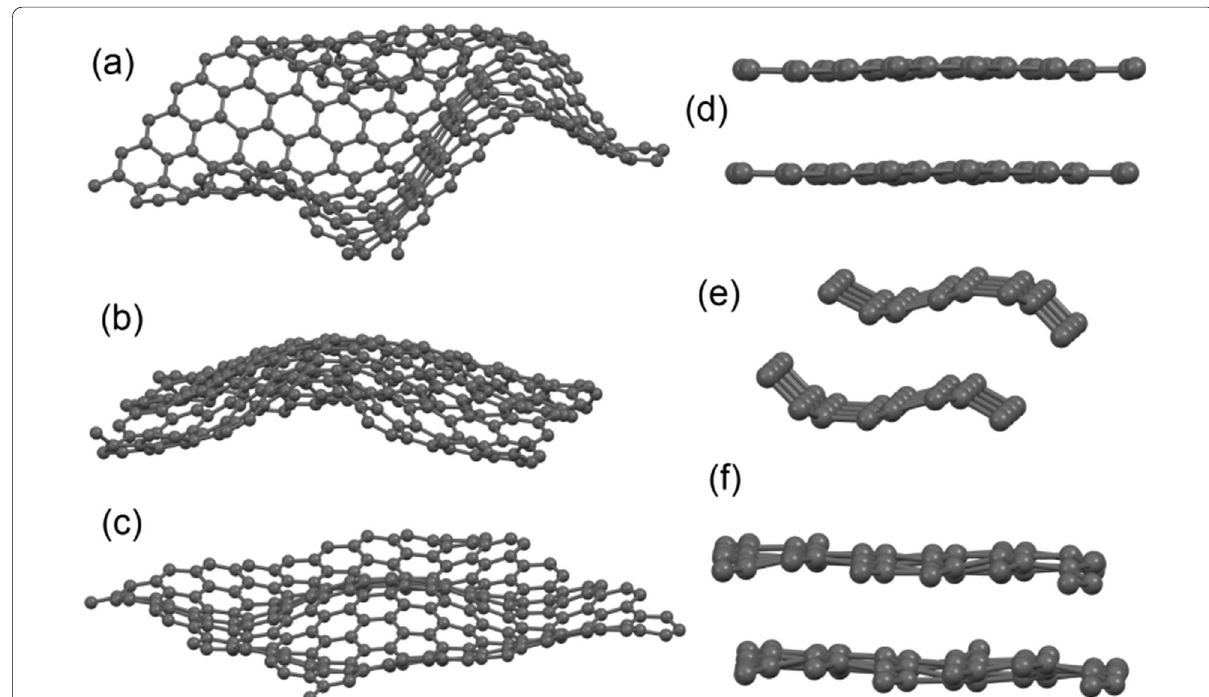
Fig. 4 Optimized atomic structures of different graphene monolayers ( a – c ) and bilayers ( d – f ) with distortions of different shapes and